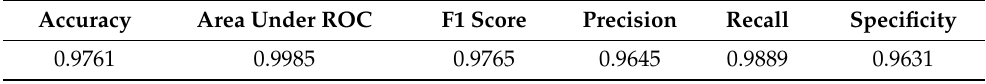
Table 4. Summary of performance metrics for